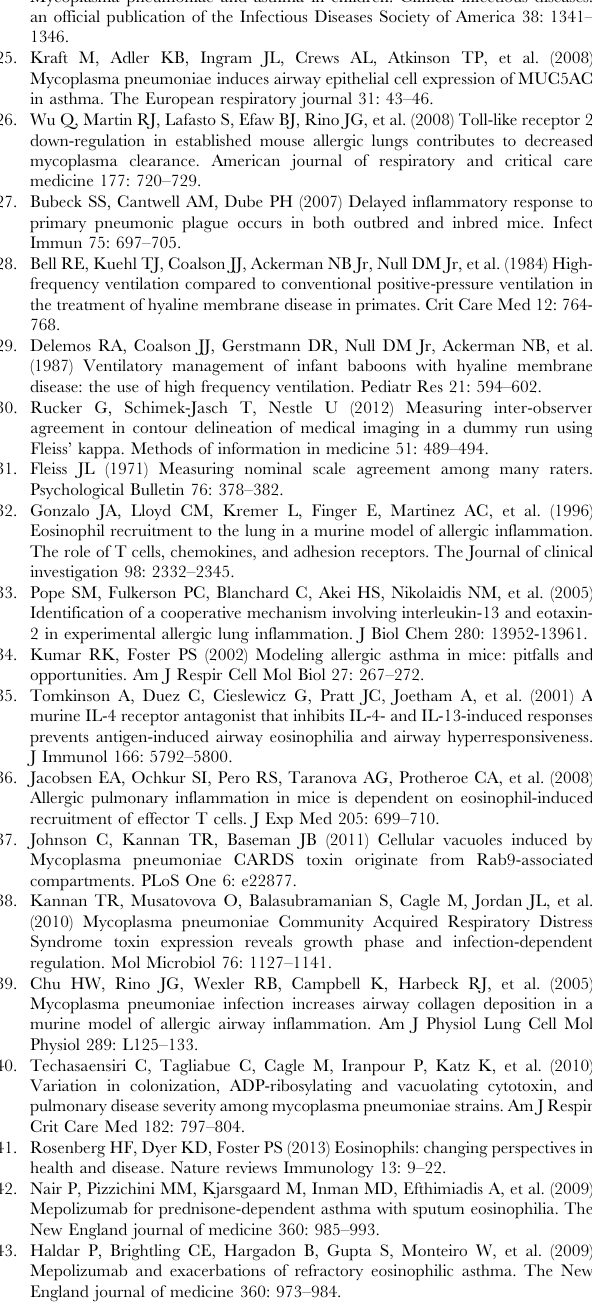
Figure S1 Panel of standards used in evaluating inflam- matory lung pathology. Whole lung H&E sections were evaluated by 4 individuals blinded to experimental treatments. (A- C) Pathology scores of 1-3 were assigned using a panel standards (A =1, B= 2, C= 3).